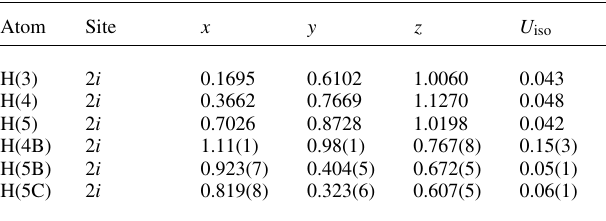
Table 2. Atomic coordinates and displacement parameters (in Å 2 ) . Table 1. Data collection and